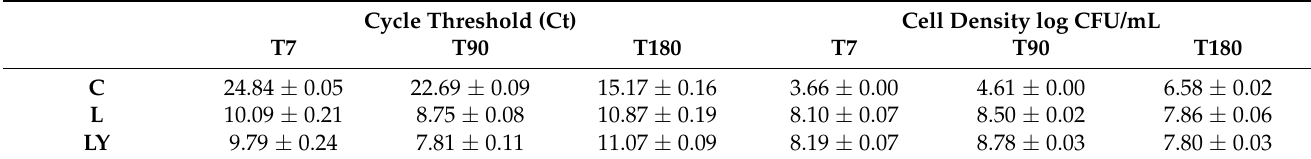
Table 3. Average values of Cycle threshold (Ct) and microbial cell density expressed as log CFU/mL of Lactobacilli population detected by qPCR in experimental table